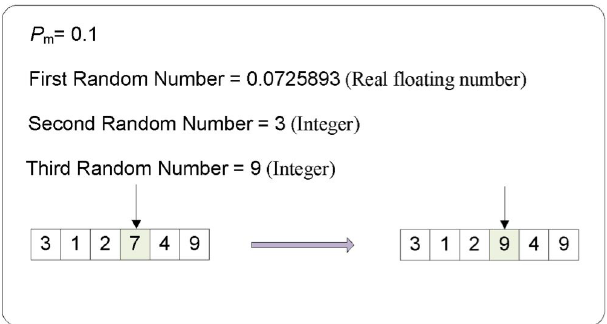
Figure 5: An example of